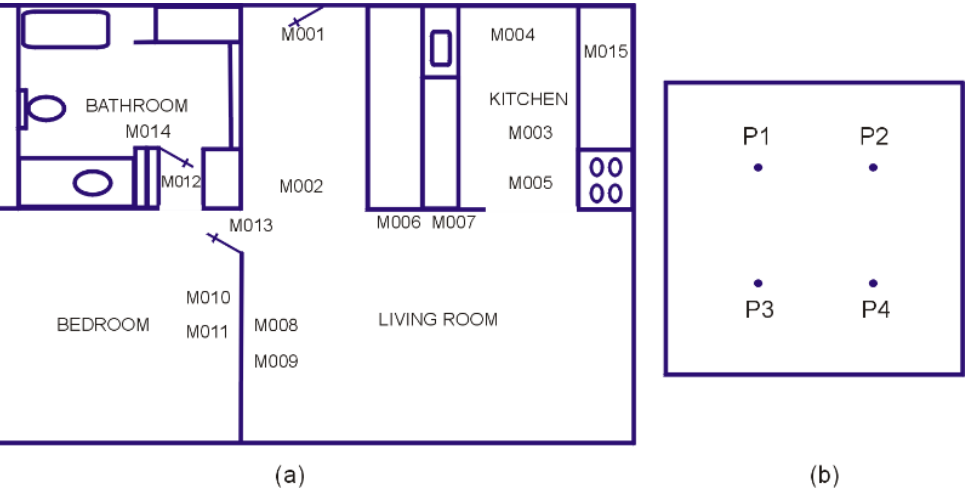
Figure 4. An illustration of the abstraction of a residential space: ( a ) the actual floor plan with the locations of the motion detectors M k and ( b ) the map of the generic 2D space indicating the locations of the behaviorally meaningful places P1-P4 (P1-bedroom, P2-Kitchen, P3-bathroom, P4-living room).